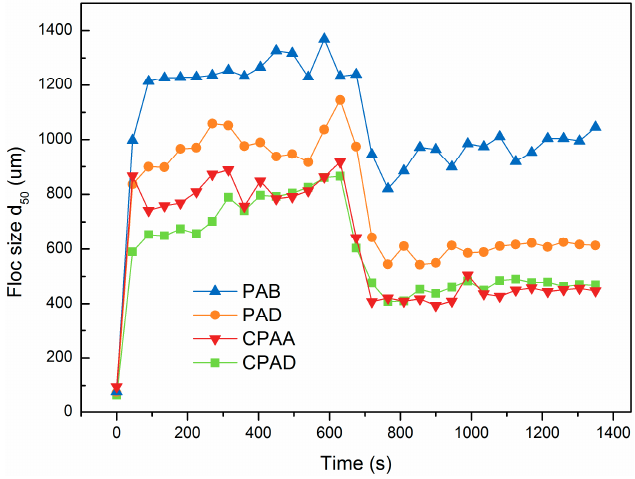
Figure 9. Effects of different sequence distribution on breakage and re-flocculation. Table 4. Floc parameters of different flocculants under the same condition.